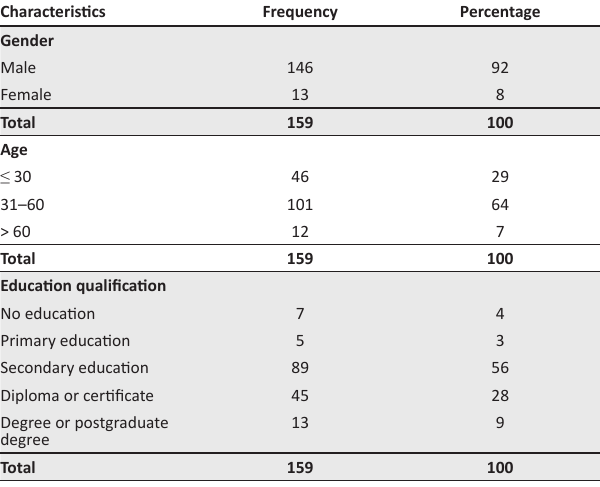
TABLE 1a: Sample demographic characteristics.